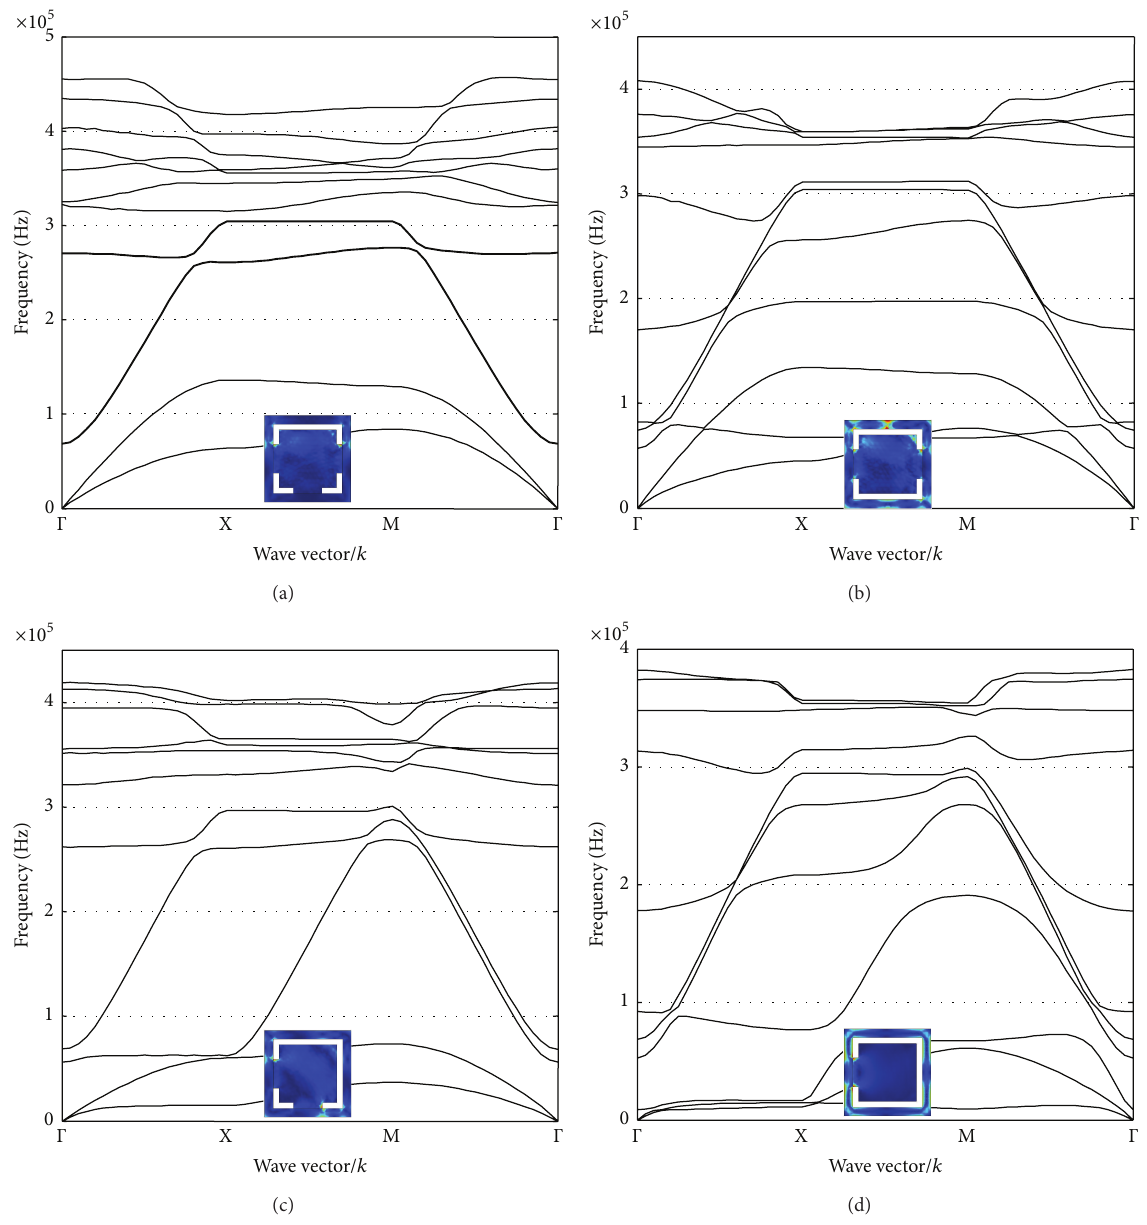
Figure 5: The dispersion curves of the phononic crystal with three connection plates (a). The dispersion curves of the phononic crystal with two opposite connection plates (b). The dispersion curves of the phononic crystal with two adjacent connection plates (c). The dispersion curves of the phononic crystal with only one connection